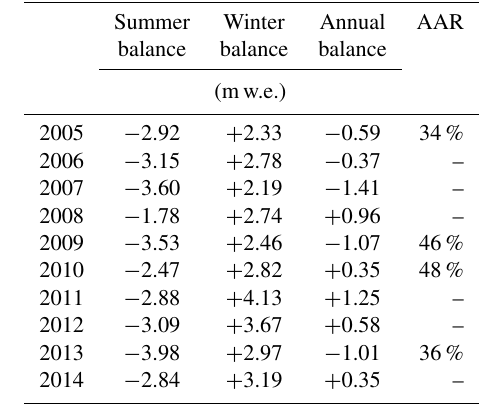
Table 1. Area-averaged glaciological mass balance values used in this study. Winter balances are as reported by Clark et al. (2017). Summer and annual balances are the result of calibration against the 2005–2014 geodetic mass balance, accomplished following the calibration steps outlined by Zemp et al. (2013). Accumulation area ratio (AAR) as reported by Clark et al. (2017) is listed for years when the seasonal snow line was